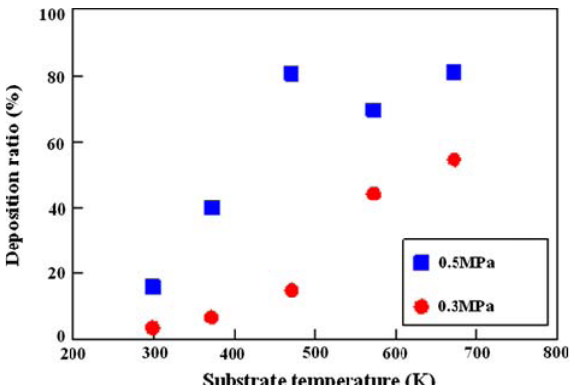
Figure 6: Relation between deposition ratio and both substrate temperature and gas pressure